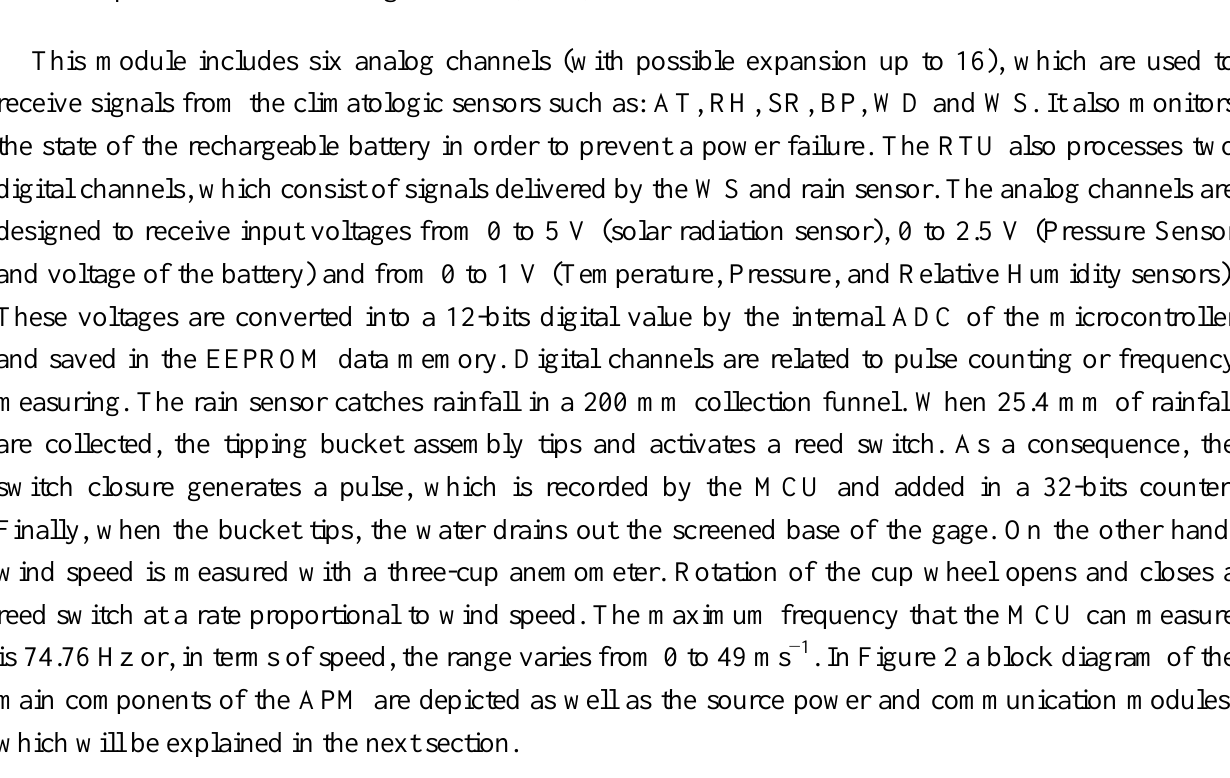
Figure 2. Block diagram of the main modules of the Remote Terminal